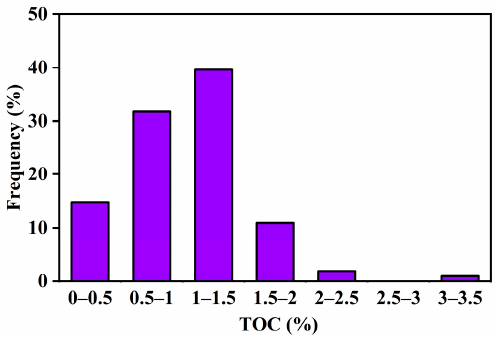
Figure 2. Distribution of TOC content. The S , obtained from the oil-washing samples, range from 0.08 mg/g to 0.19 mg/g, 1 (cid:48) with an average of 0.13 mg/g, which is significantly lower than S 1 (Figure 3a,e). The results mean that the residual oil was removed by the oil washing. The S (related to oil-washing 2 (cid:48) shales) varies from 0.24 mg/g to 0.81 mg/g, with an average of 0.59 mg/g, which is lower than S 2 (Figure 3b,f), implying that there is a part of heavy hydrocarbons that could not be detected in S 1 but calculated to S 2 . The S 1L associated with liquefrozen shale varies from 0.05 mg/g to 4.64 mg/g (mean 1.22 mg/g) and is primarily distributed in a range of 0–3 mg/g (Figure 3c). S 1L is greater than S 1 , indicating the light–medium hydrocarbon loss